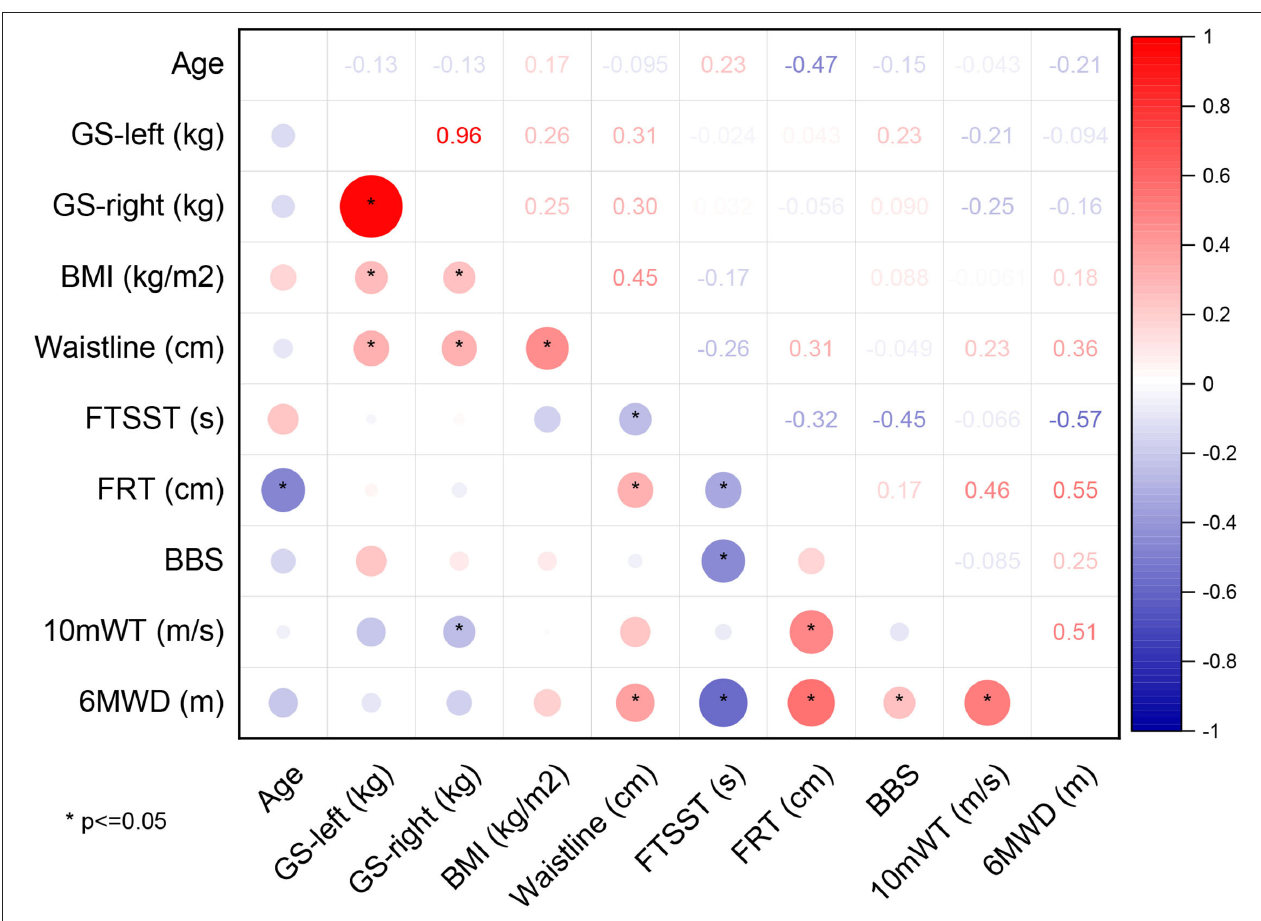
FIGURE 3 | Correlation matrix of the healthy group. GS, grip strength; BMI, body mass index; FTSST, five-times sit-to-stand test; FRT, functional reaching test; BBS, Berg Balance Scale; 10mWT, 10-m walk test; 6MWD, 6-min walk